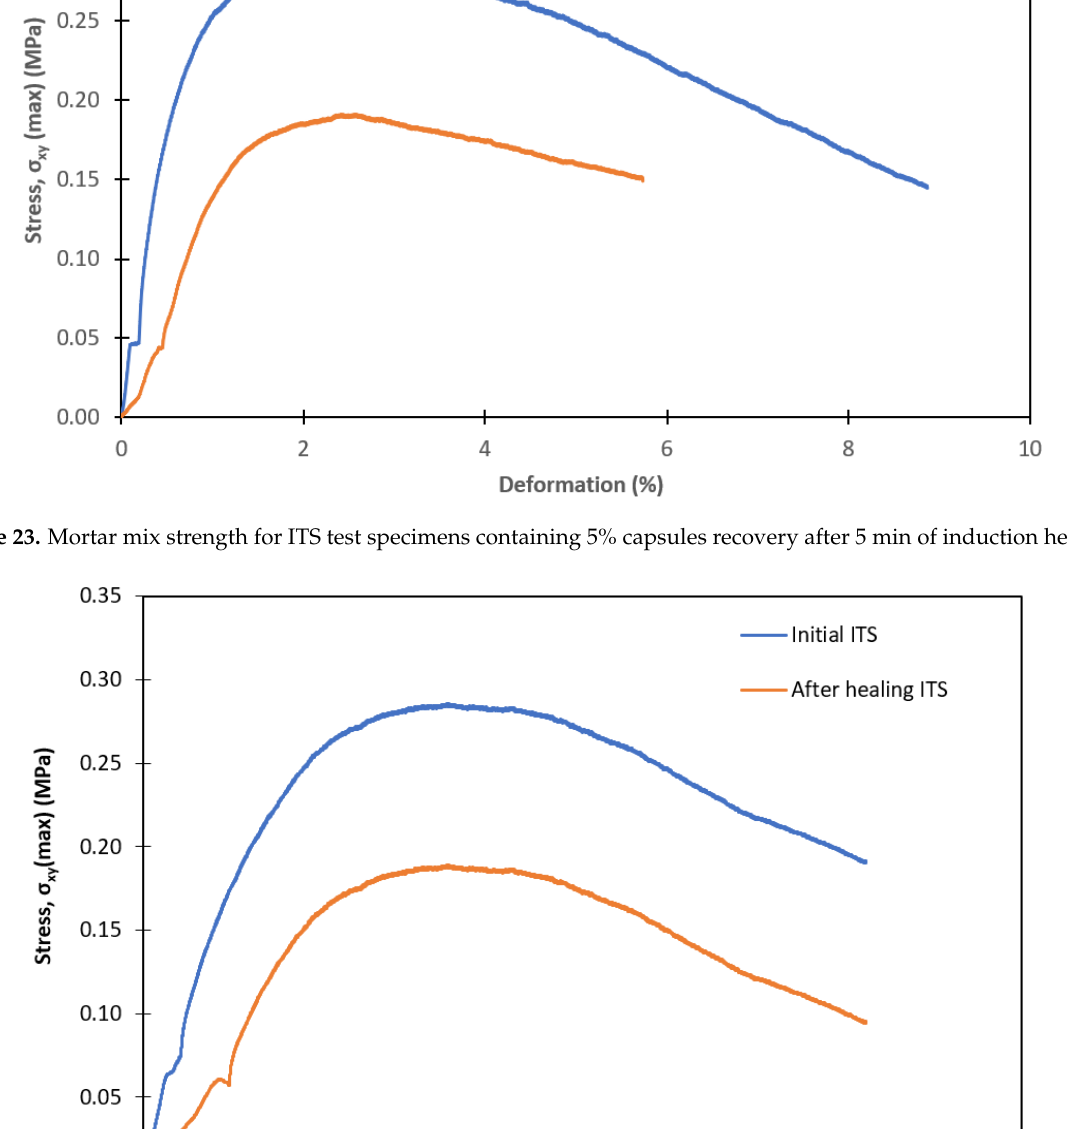
Figure 24. Mortar mix strength for ITS test specimens containing 10% capsules recovery after 5 mins of induction healing.